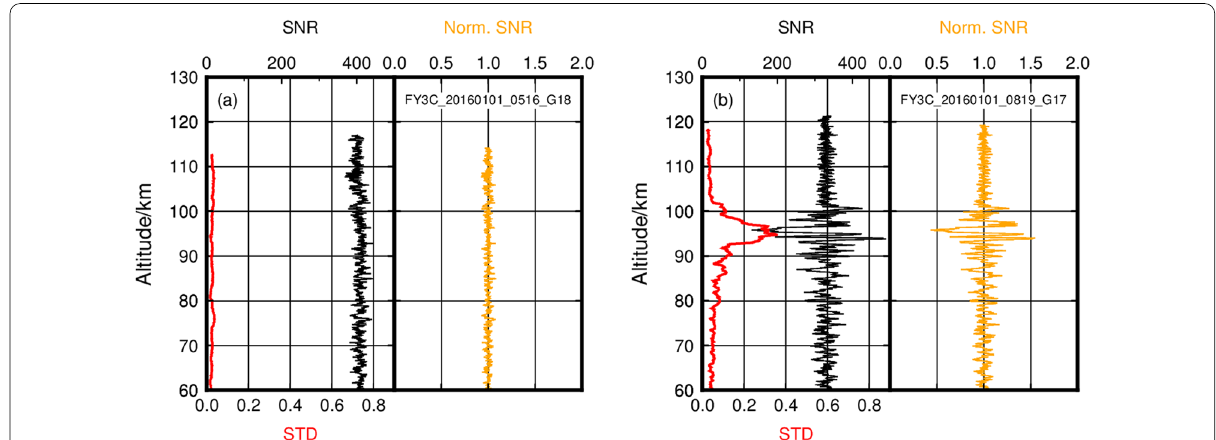
Fig. 1 Examples of the FY-3C RO observations for Es-layer detection for a without Es layers, b with an Es layer. In each subfigure, the three profiles represent the original L1 SNR profile (in black), the normalized SNR profile (in yellow), and the STD profile (in red), and the identifier of each RO event is shown in the upper right corner of the